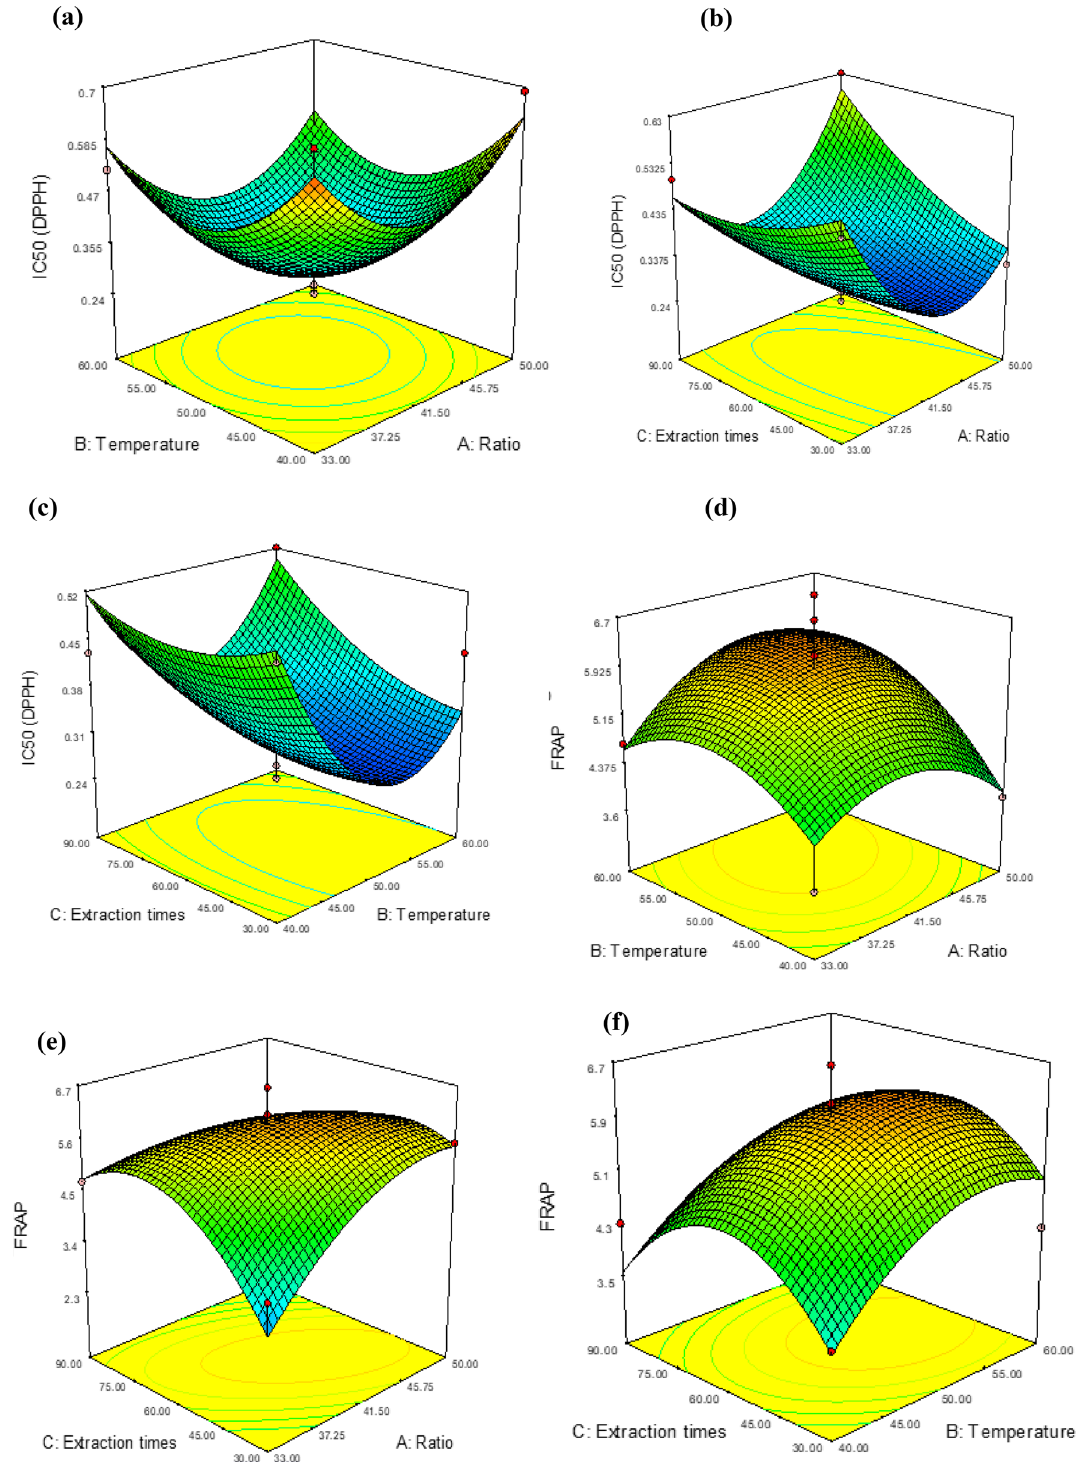
Figure 2. Response plots showing the effect of ratio ( A ), extraction temperature ( B ), extraction times ( C ) on DPPH and FRAP antioxidant